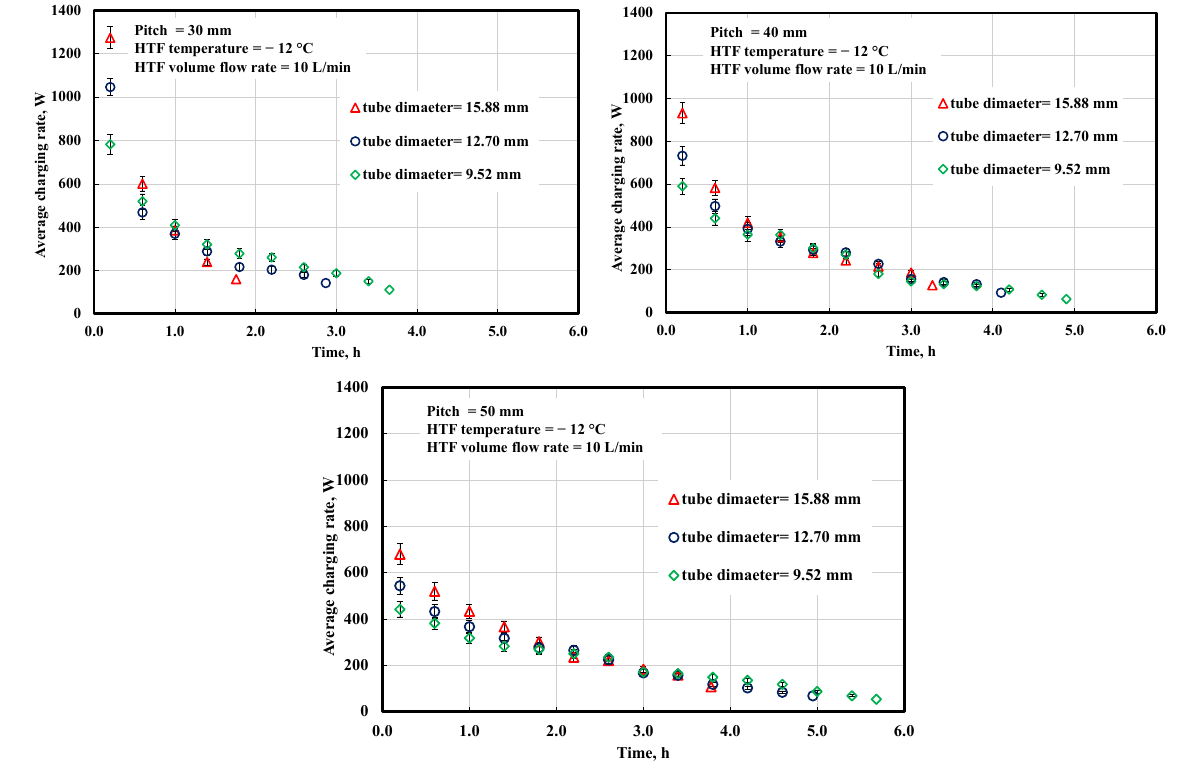
Figure 9. Average charging rate versus time using various tube diameters with different pitches during the charging process.